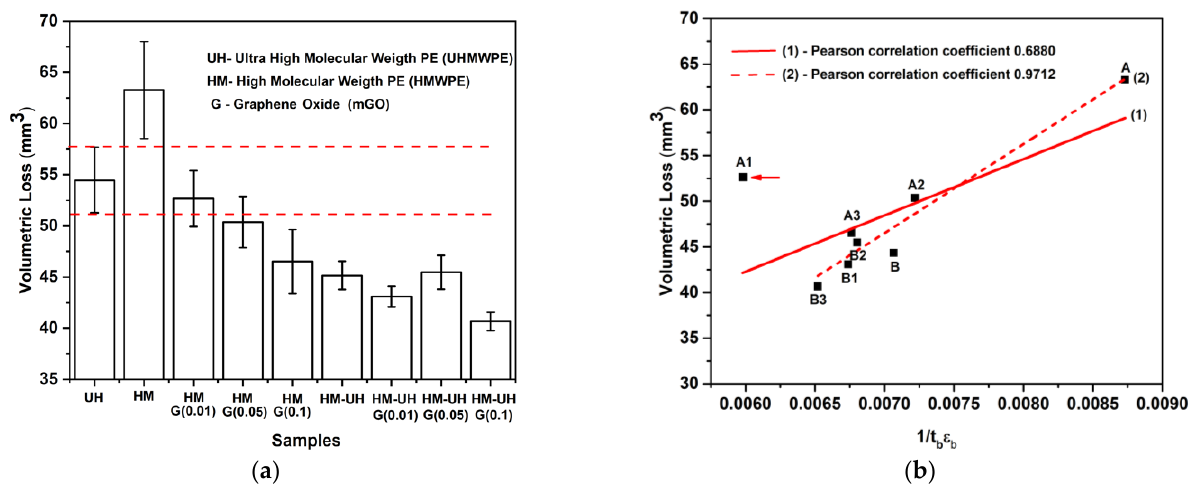
Figure 4. Results of volumetric loss after abrasive test ( a ) and Ratner–Lancaster correlation ( b ) of the UHMWPE [11], HMWPE (A) [11], HMWPE-mGO (0.01 (A1), 0.05 (A2) and 0.1 (A3) wt.%), HMWPE-UHMWPE (80/20 wt.%) (B) [11] and HMWPE-UHMWPE (80/20 wt.%)-mGO (0.01 (B1), 0.05 (B2) and 0.1 (B3) wt.%).